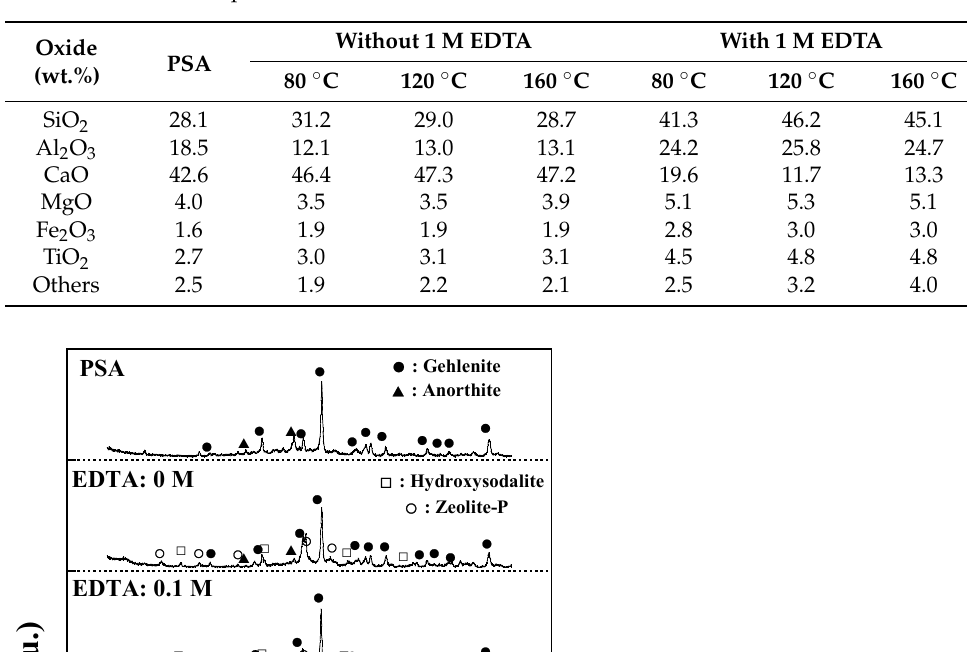
Table 1. Chemical compositions of the PSA.